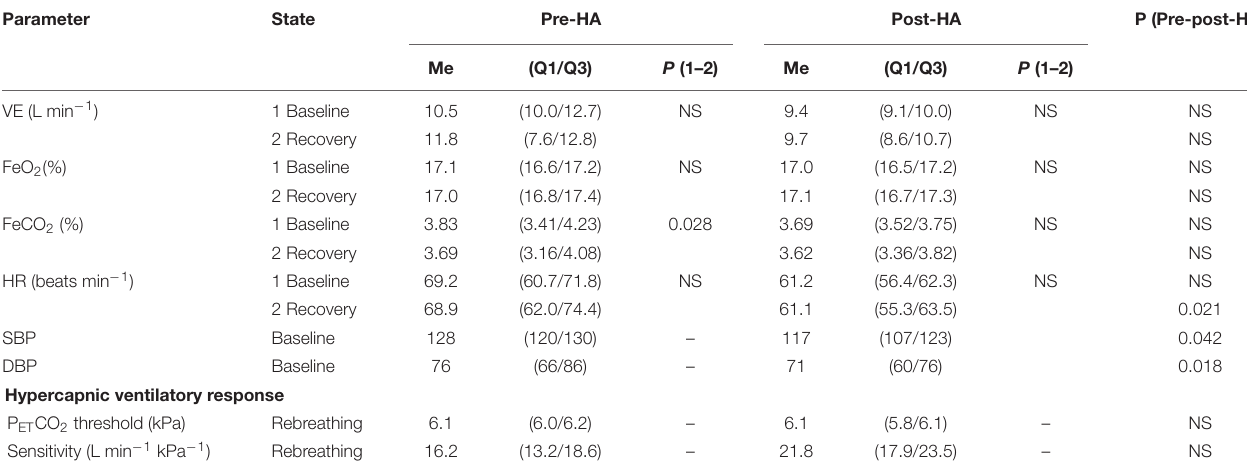
TABLE 1 | Cardiorespiratory parameters and rebreathing test data pre- and post- high altitude. Parameter